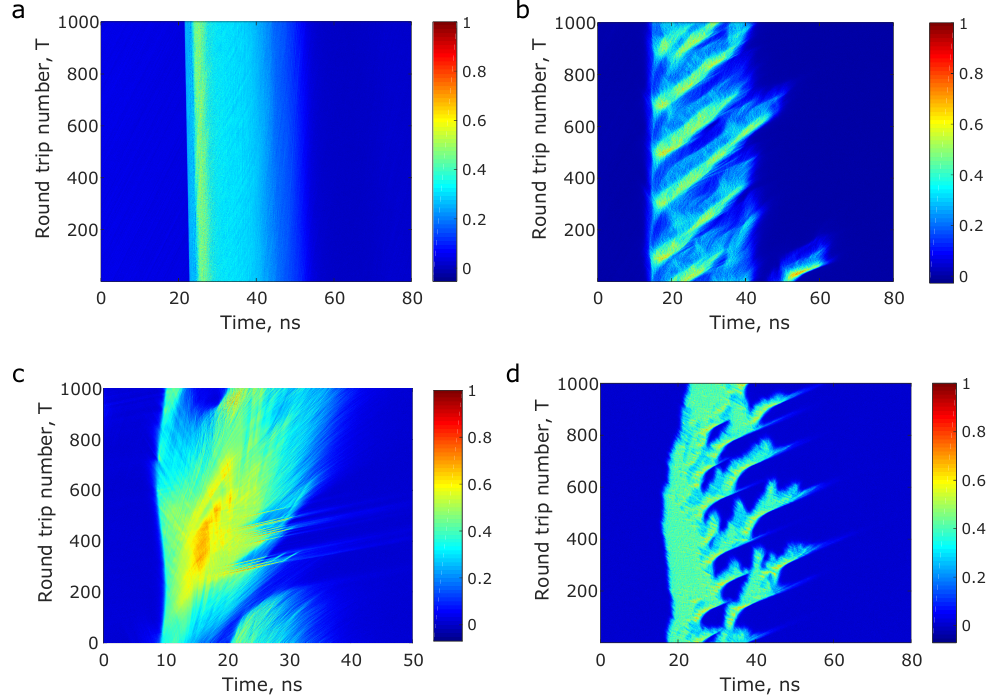
Figure 6. Spatio-temporal diversity of the partially mode locked regimes—Different spatio-temporal regimes with varying characteristics accessed via tuning of the polarization controllers. The panels give examples of regimes exhibiting ( a ) stationary characteristics over evolution co-ordinate T; ( b ) periodicity over evolution co-ordinate T; ( c ) interactions between the pulse and the background; and ( d ) highly chaotic, turbulent